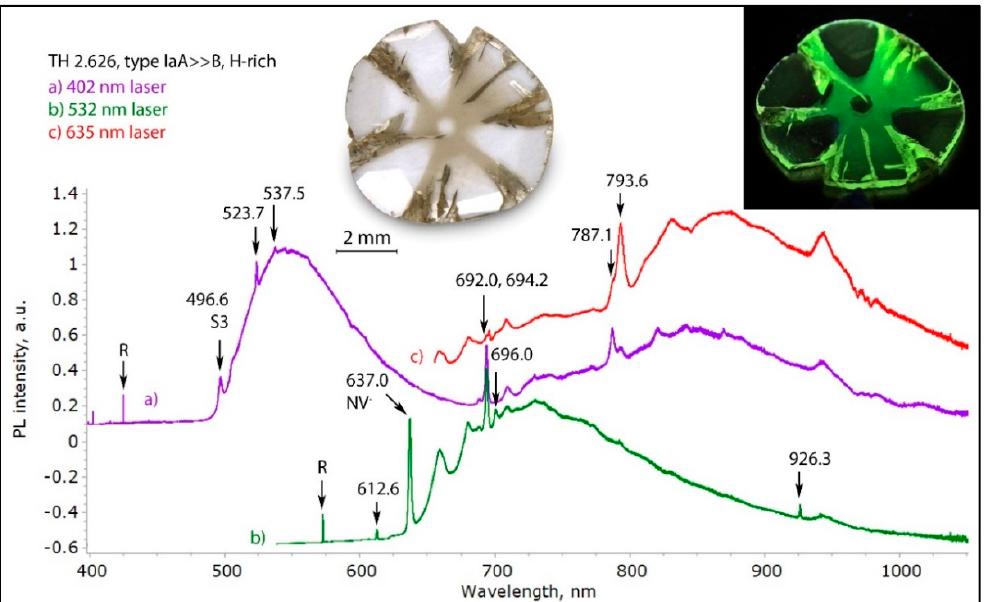
Figure 23. The photoluminescence spectra of the brown sectors of an NDR hydrogen-rich “asteriated” colorless/brown type IaA >> B diamond (TH 2.626) recorded with three different lasers. The intense broad vibronic S3 band centered at about 545 nm is related to nickel defects and responsible for the green fluorescence of the brown sectors of the diamond. The 692.0/694.2 doublet, the 787.0 and the 793.6 nm centers are characteristic for such diamonds, and all of these are likely related to nickel containing defects. The spectra have been shifted vertically for clarity. Photos: Gianna Pamies and Dr. Thomas Hainschwang.